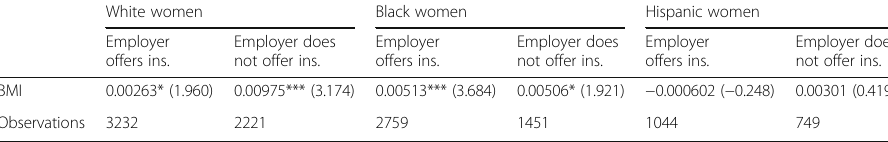
Table 8 BMI and log hours of work for single women : by availability of employer-provided insurance White women Black women Hispanic